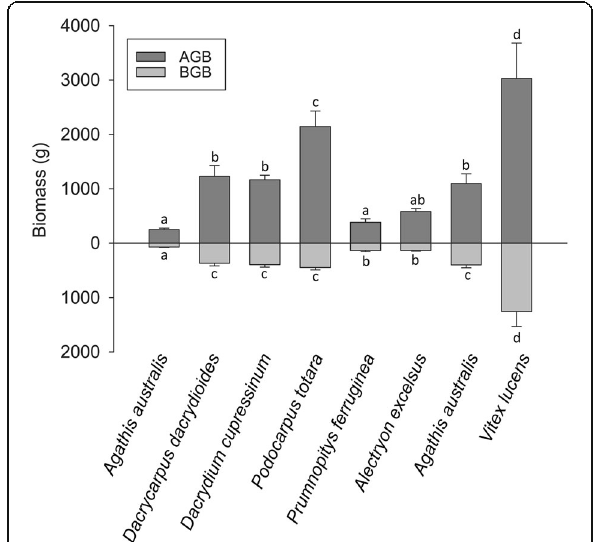
Fig. 5 Plant biomass above- (dark bars) and below-ground (light bars) in year 5. Error bars represent one standard error of the mean. Bars within each parameter with a different letter were significantly different ( P =